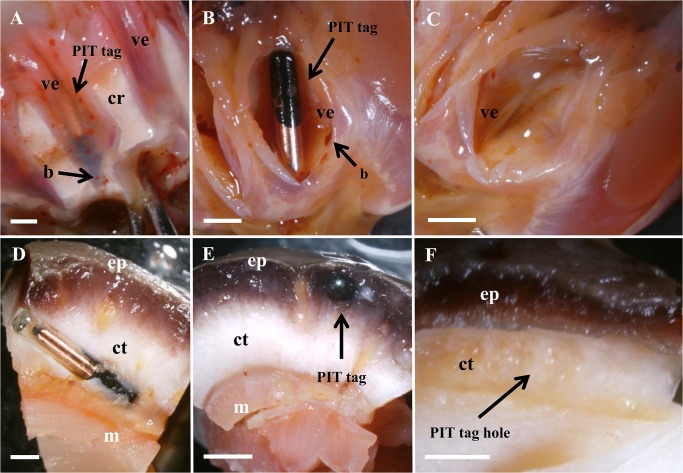
Localisation of retained PIT tags.(A-C) Tags retained in the aquapharyngeal bulb were found in the vesicles of the tentacles (ve). The calcareous ring (cr) and brown bodies (b) are identified. (D-F) Tags retained in the body wall were implanted in the connective tissue (ct) between the epidermis (ep) and the longitudinal muscle bands (m) below the ambulacral podia. Scale bars represent 2 mm.